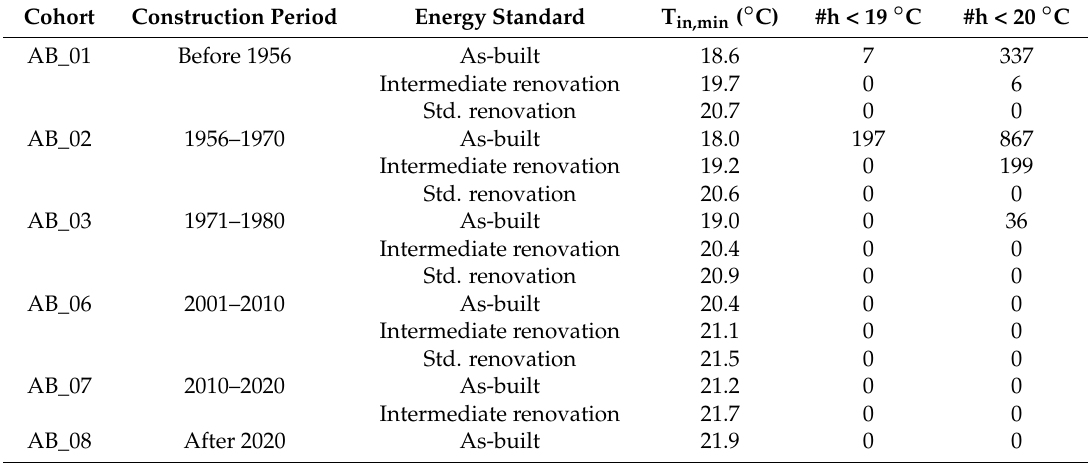
Table 4. Minimum indoor air temperature and number of hours with temperatures below 19 and 20 ◦ C for the different models with temperature level 60/40 ◦ C, collected from day room at ground floor gable wall.